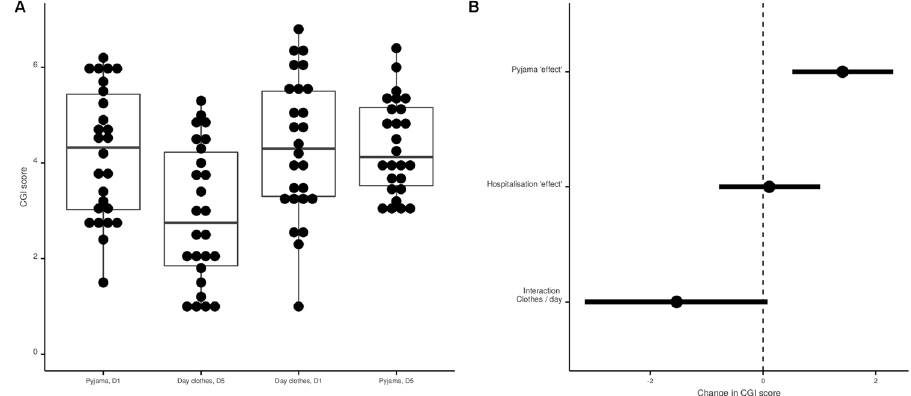
Figure 5. Pyjama and hospitalization effects and interaction on Clinical Global Impressions (CGI). Panel A: Distribution of CGI scores at Day 1 (D1) and Day 5 (D5) in the day clothes and pyjama conditions. Data are presented for descriptive purposes only. The dots represent each value for each patient (a given patient has 2 values in each condition). Panel B: CGI analysis; Forest plot of coefficients and their 95% confidence interval observed with the mixed model including an interaction (mixed model performed with the “patient” and the “psychiatrist” factors specified as random effects). Negative values for the interaction term (Clothes/days) means that the positive effect perceived after 5 days of hospitalization is more marked when patients are in day clothes than in